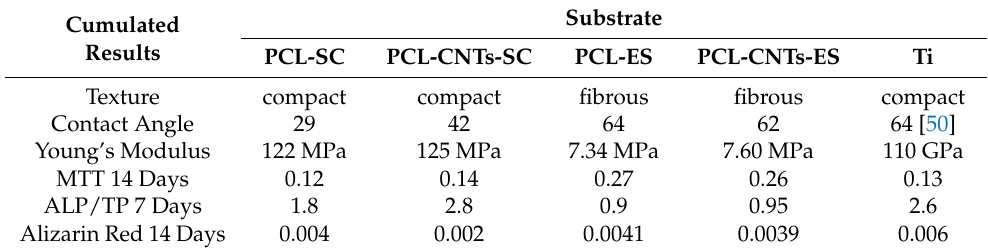
Table 6. Cumulated results for the four tested substrates vs.